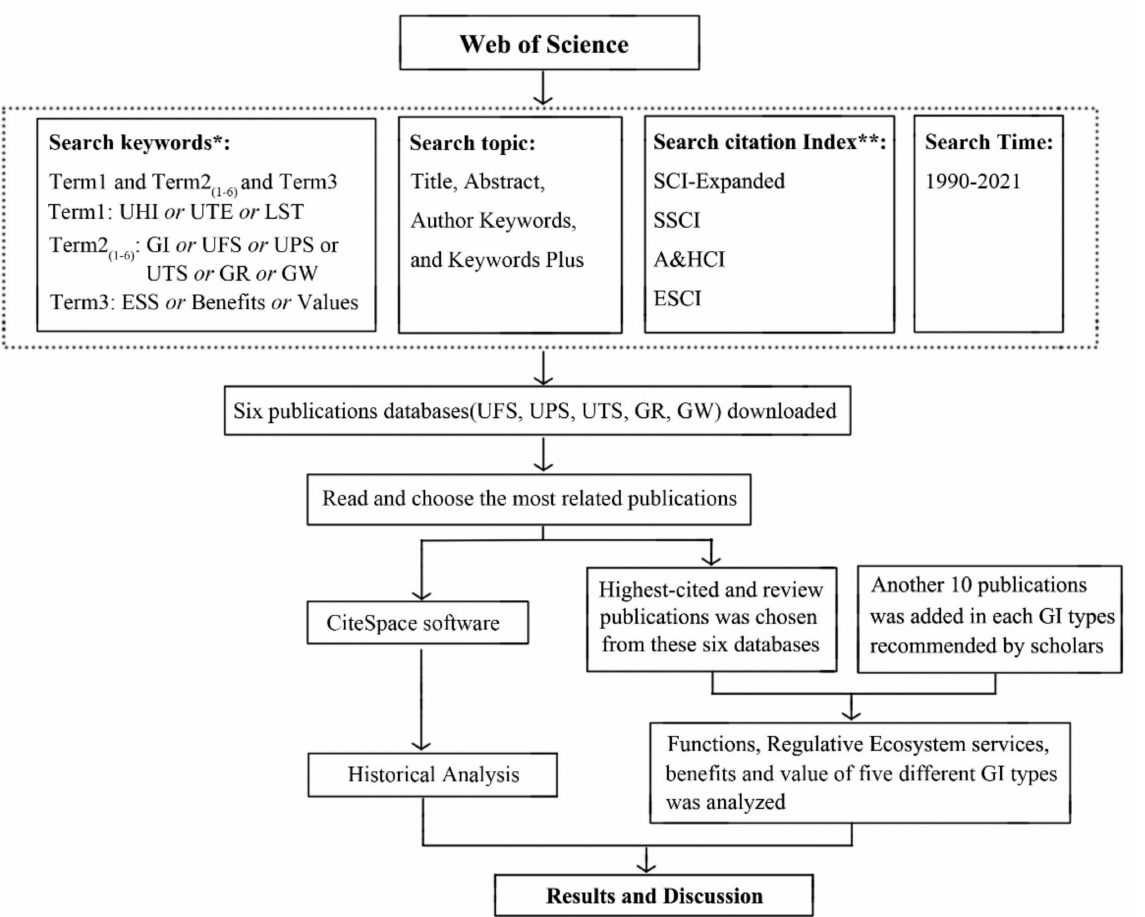
Figure 1. The diagram of methodology. *: UHI: urban heat island, UTE: urban thermal environment, LST: land surface temperature; GI: green infrastructure, UPS: urban parks, UFS: urban forests, UTS: green streets OR street trees, GR: green roofs OR eco-roof OR living roof OR vegetate roof OR roof garden OR roof greening, GW: green wall OR vertical greenery system OR green facades; ESS: ecosystem services. **: SCI-Expanded: Science Citation Index Expanded, 1900–present, SSCI: